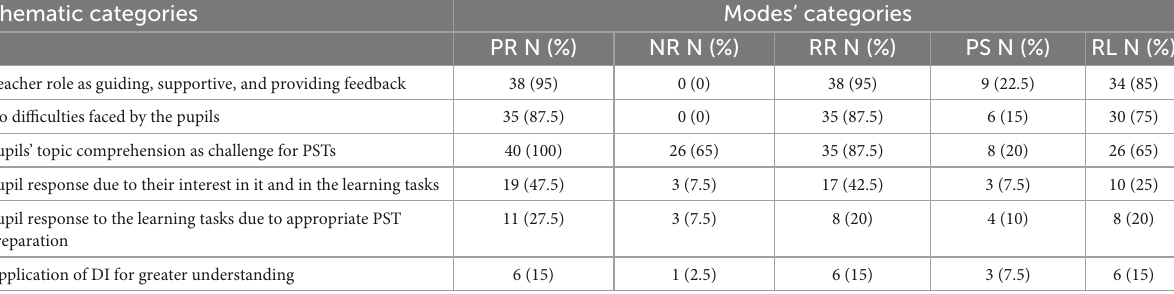
TABLE 1 Pre-service teachers’ modes of expressing their positions regarding pupils’ content comprehension in the project-based learning (Pj-BL) approach. Thematic